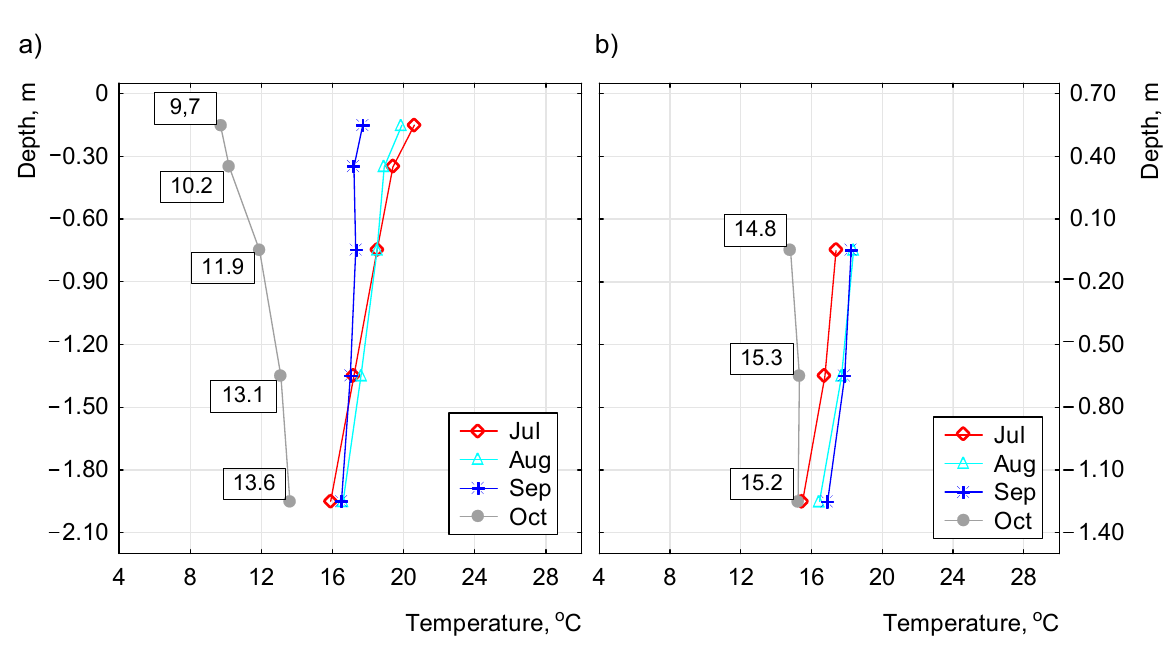
Figure 8. Monthly average ground temperature profiles at various depths, 1 July–31 October: ( a ) Profile II; ( b ) Profile I.